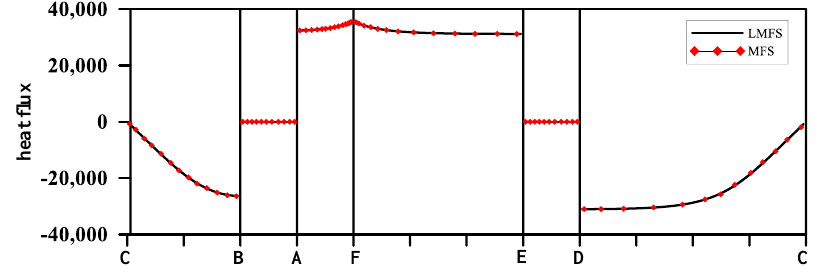
Figure 6. The heat flux on the boundary when a = 0.25.